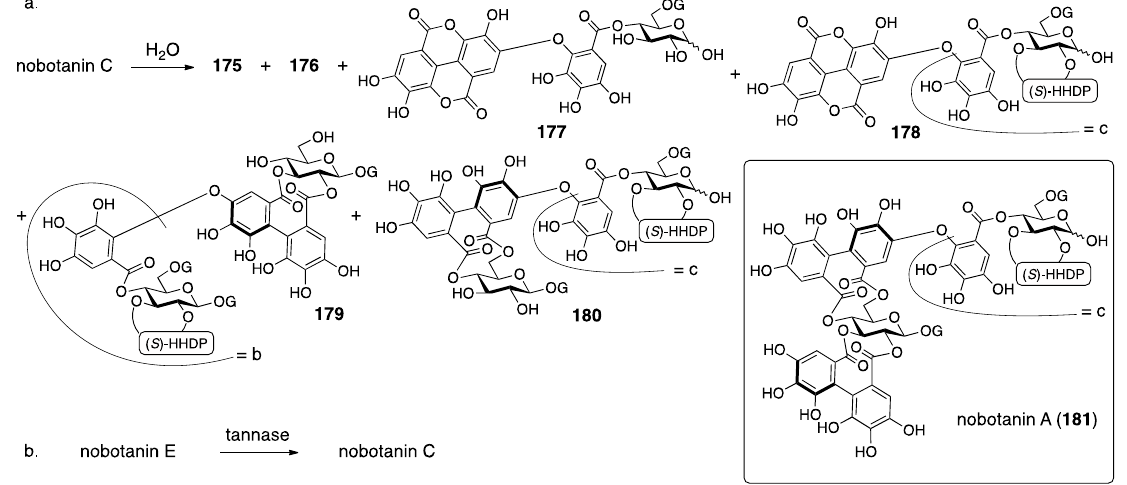
Figure 55. The information referred to in the structural determination of the first structures of